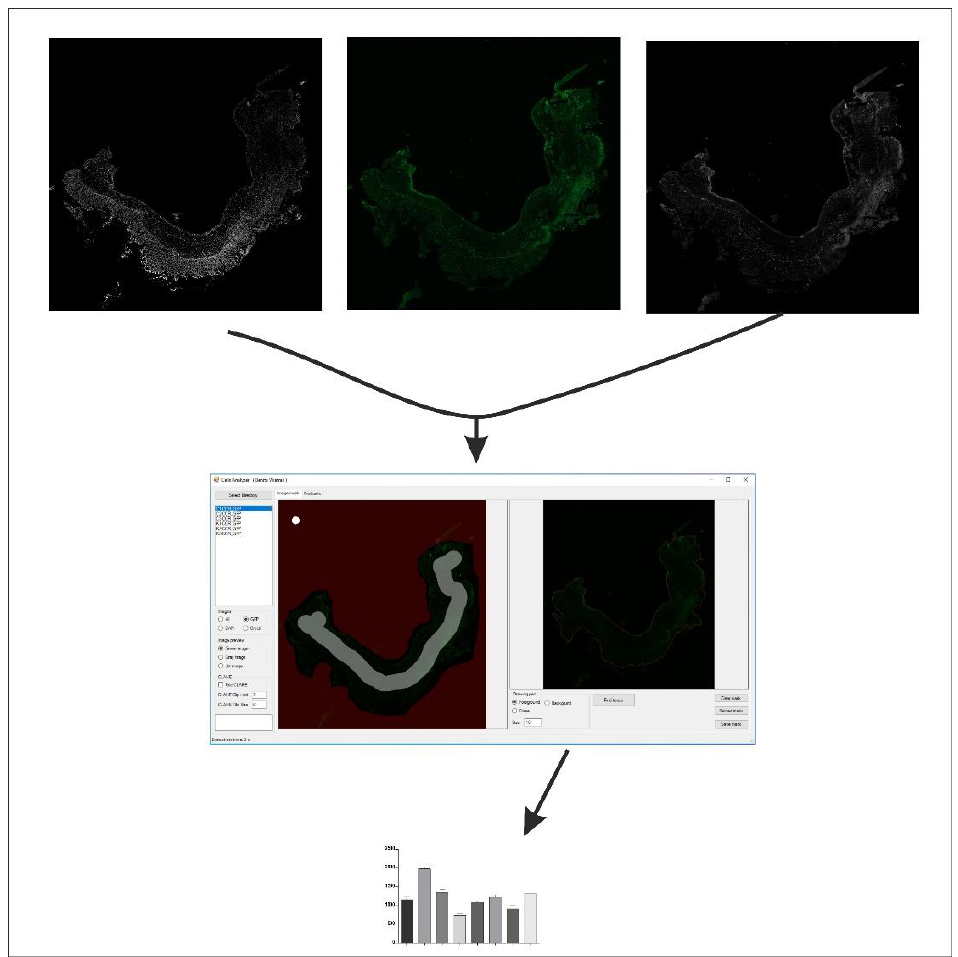
Figure 12. Scheme of the process of quantitative analysis of the level of protein expression performed with the use of proprietary software; magnification 4×.